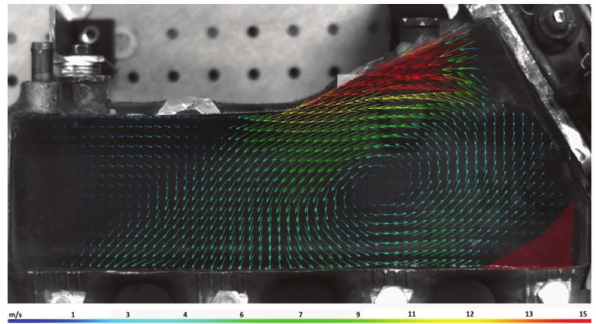
Fig. 11. Velocity vector distribution and air flow direction in the intake manifold at 2000 RPM engine speed and 20˚ throttle position angle